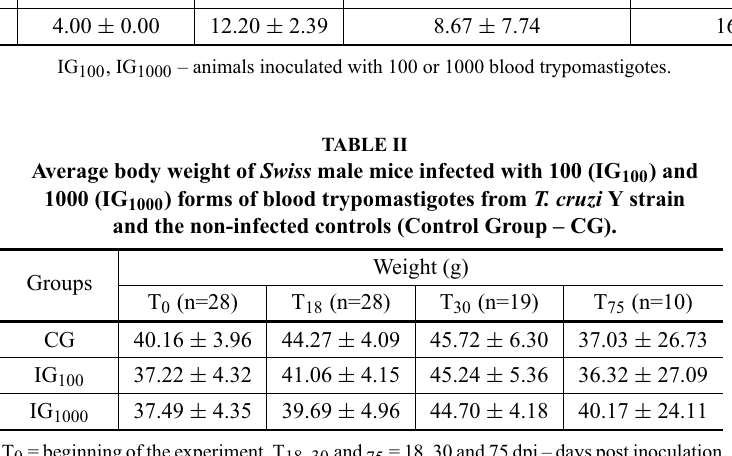
Parasitological parameters evaluated in 60-day-old Swiss male mice experimentally infected by T. cruzi Y strain. Group